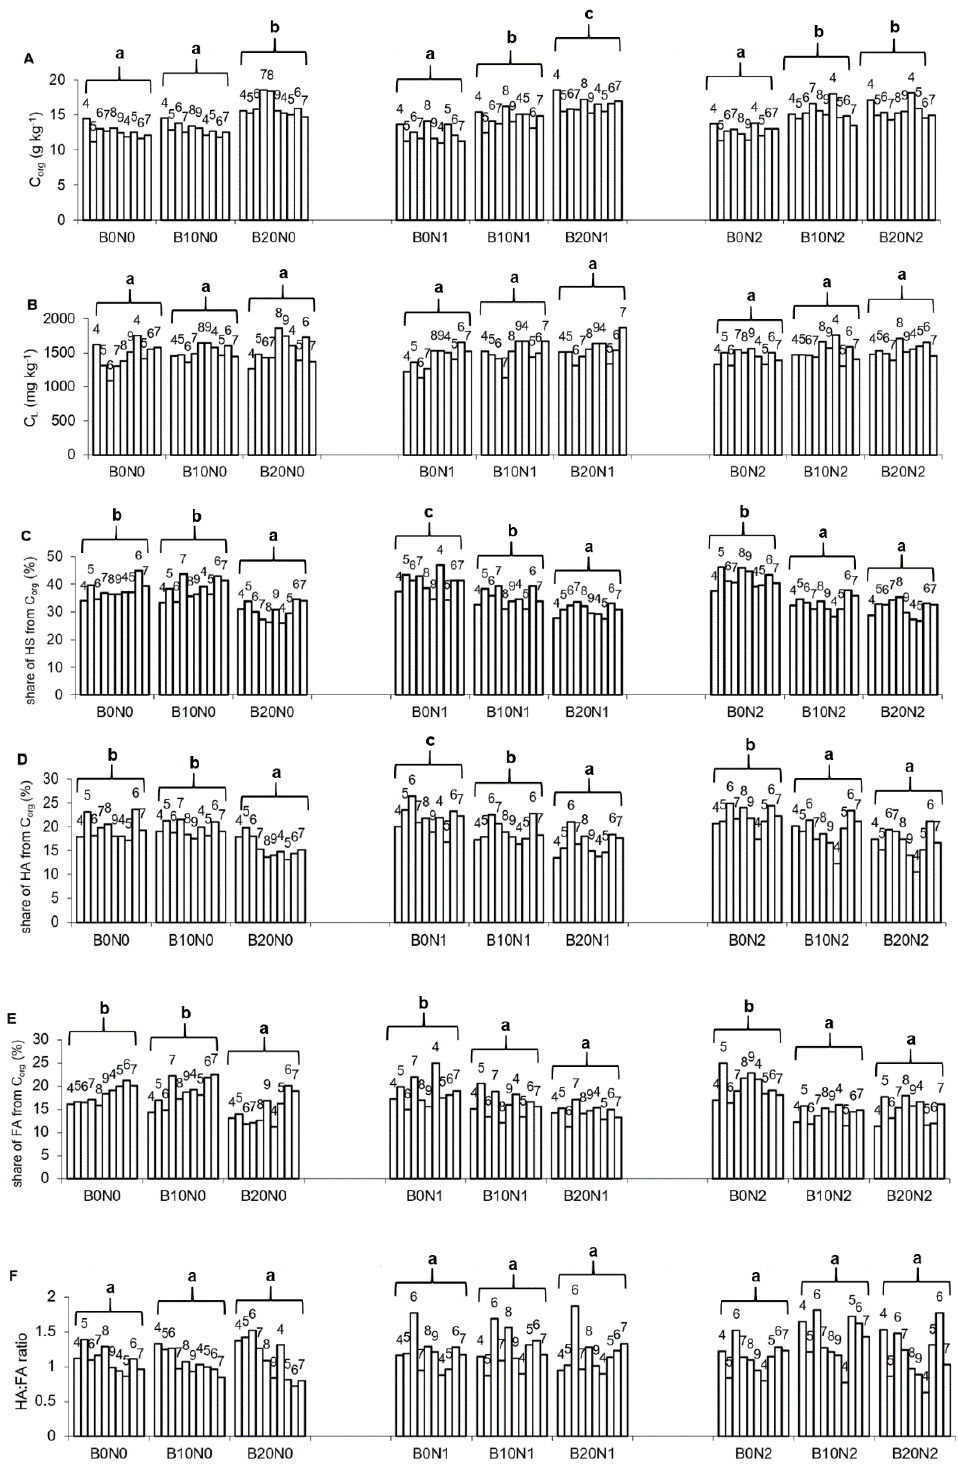
Figure 2. Dynamics of soil organic matter and humus parameters during the vegetation season in 2017 – 2018: ( A ) soil organic carbon, ( B ) labile carbon, ( C ) humus substances, ( D ) humic acids, ( E ) fulvic acids, ( F ) humic acids to fulvic acids ration. Treatments are mentioned in the Material and Methods Section. The vegetation season in 2017 represents April to September and in 2018, from April to July (4: April, 5: May, 6: June, 7: July, 8: August, 9: September). Different letters (a, b, c) indicate that treatment means are significantly different at p ≤ 0.05 according to the LSD multiple-range test.